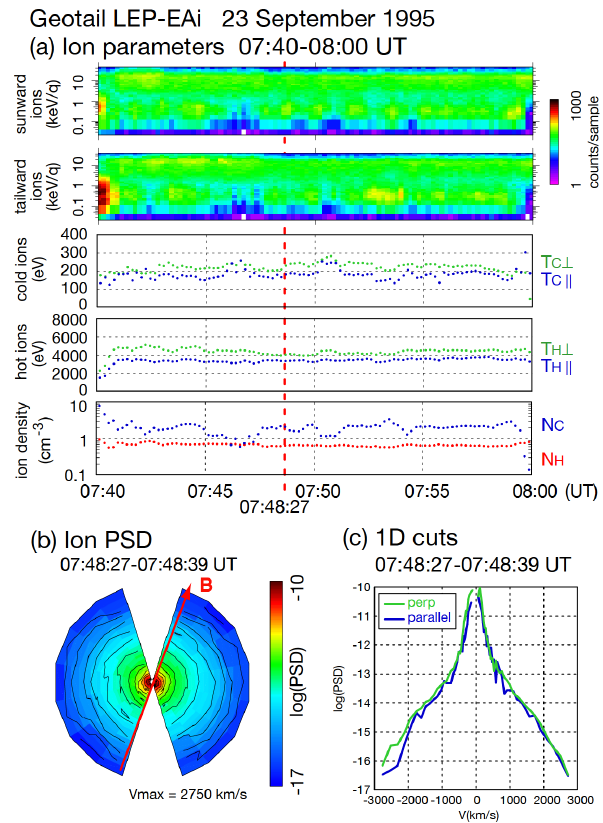
Fig. 4. The upper panel shows the Geotail observations between 07:40–08:00 UT on 23 September 1995, in the same format as Fig 2. The lower panel shows a cut of ion phase space density for the